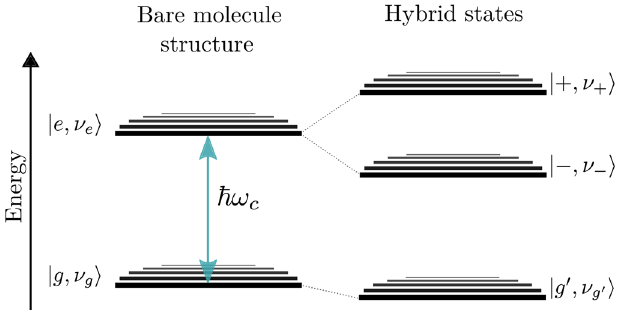
FIG. 1. Illustration of energy level structure of a bare complex molecule and the hybrid states that result in the strong-coupling regime with a photonic mode of energy ℏ ω molecular